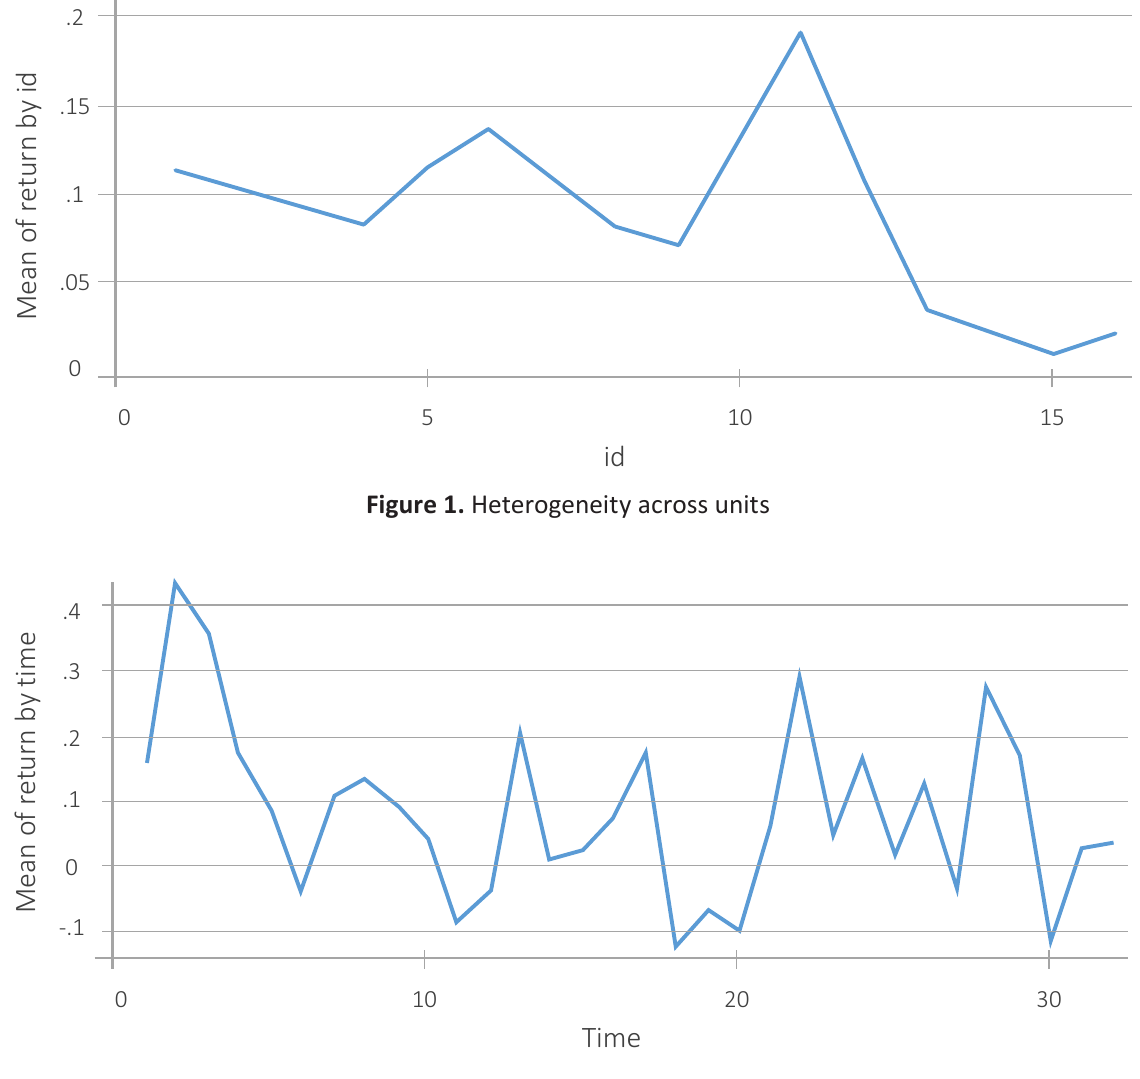
Figure 2. Heterogeneity across periods